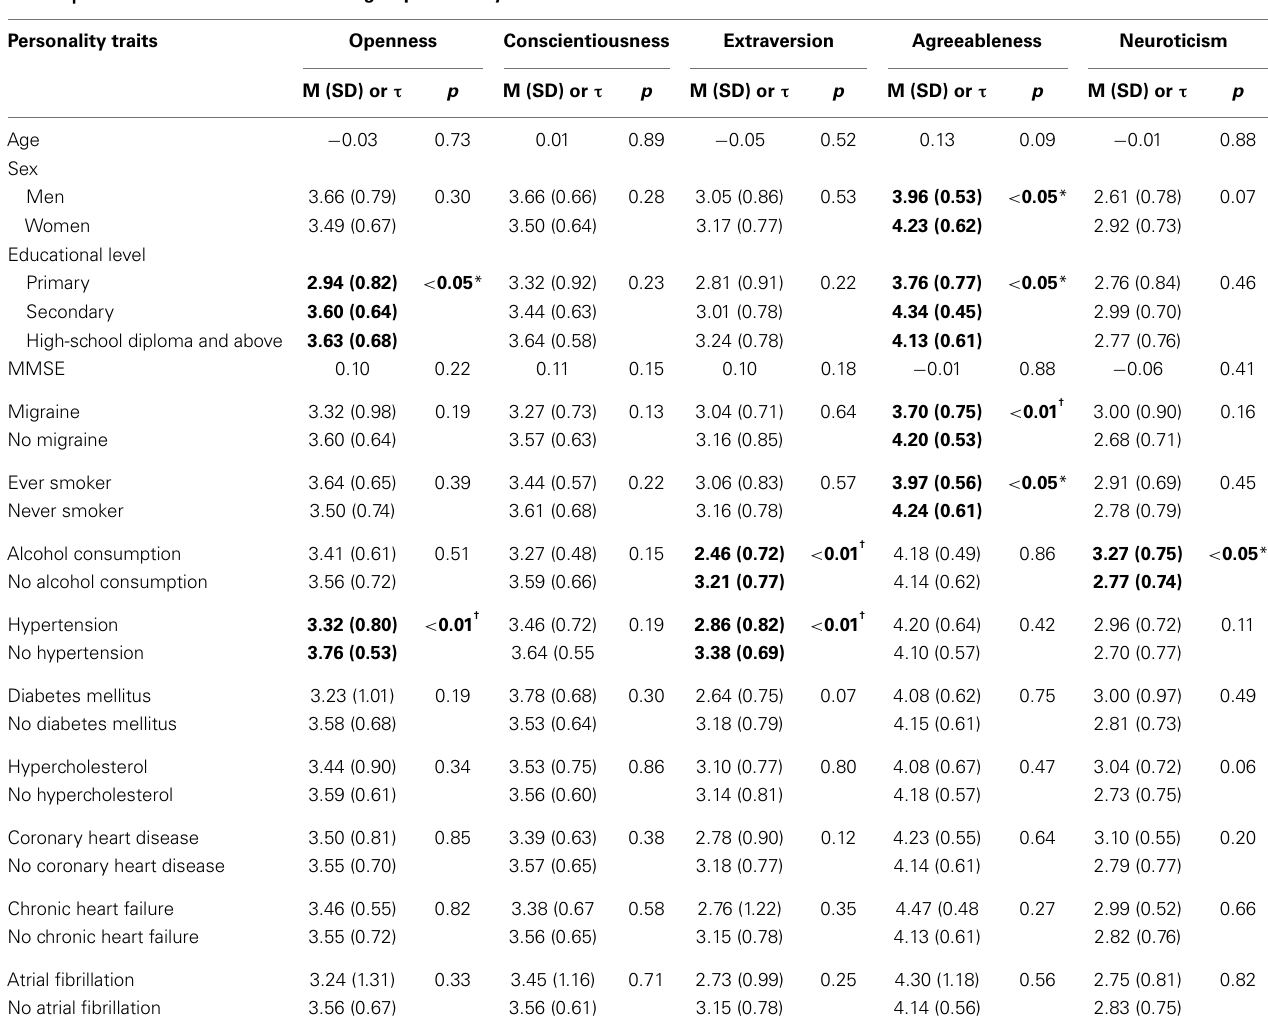
Table 3 | General characteristics according to personality traits